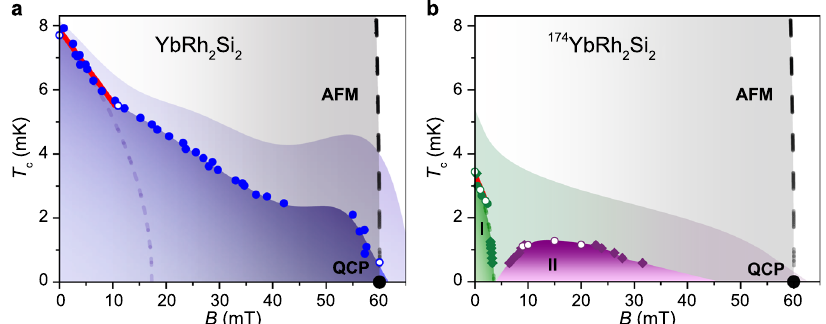
Fig. 4 Temperature – magnetic fi eld phase diagrams of YbRh 2 Si 2 and 174 YbRh 2 Si 2 . a Results for YbRh 2 Si 2 . b Results for 174 YbRh 2 Si 2 . Open ( T c ) and full ( B c2 ) circles of all colors represent midpoints (50%) of the resistive transitions of iso- B ρ ( T ) curves (Fig. 1c, d) T iso- T ρ ( B ) curves (Fig. 2a, b), respectively. Full diamonds represent the B c2 values extracted from a multi-transition model (Supplementary Note 1: Analysis of resistivity vs magnetic fi eld isotherms and Supplementary Fig. 1) for the three involved transitions (green for leaving phase I, violet for entering and leaving phase II). The good agreement between diamonds and circles in the regions of minimal multi-phase interference justi fi es this procedure. The upper boundaries of the pale shaded areas away from data points represent 90% resistance lines. The black dashed line in both panels indicates the boundary of the antiferromagnetic (AFM) phase. It represents an extrapolation of data from refs. 28,29 , to T = 0, the quantum critical point (QCP, black dot). The red lines are linear fi ts to the low- fi eld (50%) data, and determine both the upper critical fi eld slopes (cid:1) dB c2 = dT j T and the zero- fi eld superconducting transition temperatures T c [ = T c ( H = 0)]. c ð T Þ ¼ B 0 ð T ¼ 0 Þ (cid:4) ½ 1 (cid:1) ð T = T Þ 2 (cid:5) mean- fi eld curves determined from (cid:1) dB = dT j T The dashed lines represent (inverted) B 0 T c and c , as estimates of the (low- c c2 c2 c2 fi eld) phase boundaries. Below 0.5 mK, all other phase/shading boundaries correspond to linear-in- B extrapolations of fi ts to the lowest T data points. Note that the perfect overlap of the full and open symbols demonstrates the high reproducibility of the results.